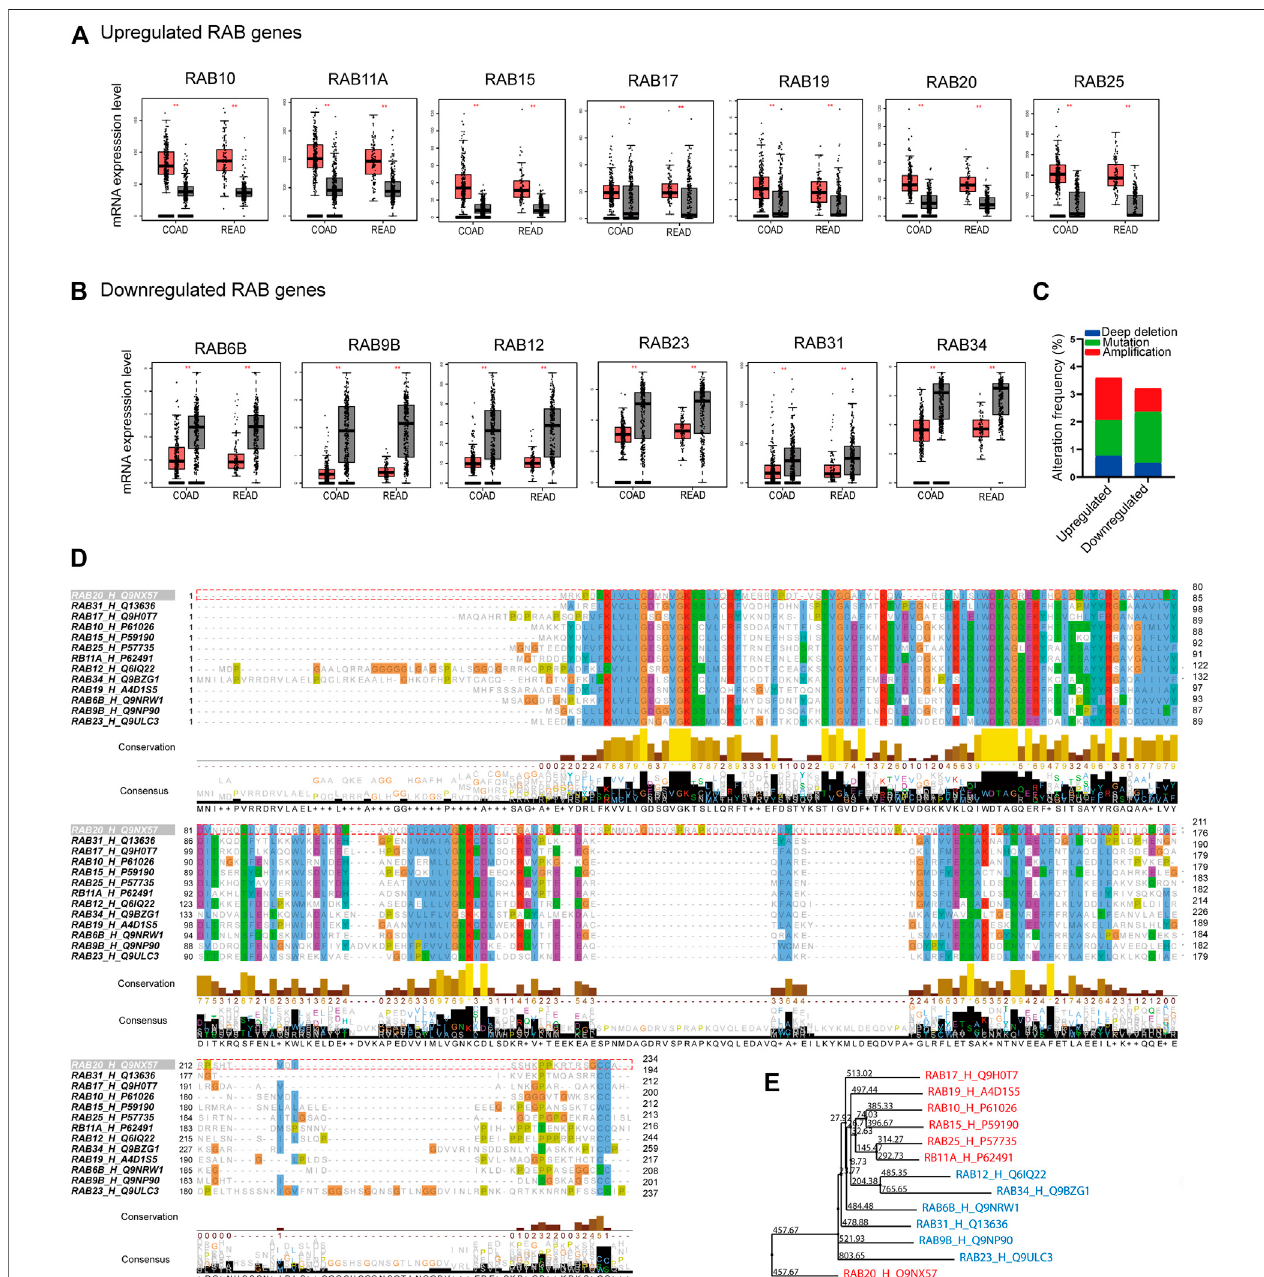
FIGURE 1 | Differentially expressed RABs, genetic alteration, and sequence alignment of the RABs in colorectal cancer. (A) 7 RABs (RAB10, RAB11A, RAB15, RAB17, RAB19, RAB20, and RAB25) were signi fi cantly upregulated in tumor tissues. (B) 6 RABs (RAB6B, RAB9B, RAB12, RAB23, RAB31, and RAB34) were signi fi cantly downregulated in tumor tissues. Red and grey bar represents tumor and normal tissues, respectively. Tumor tissues (COAD: n = 275, READ: n = 92) and normal tissues (COAD: n = 349, READ: n = 318). (C) Genetic alterations frequency of each RABs in 2544 CRC patients. (D) Sequence alignment of the RABs. (E) Phylogenetic tree of the maximum likelihood analysis. ** p <